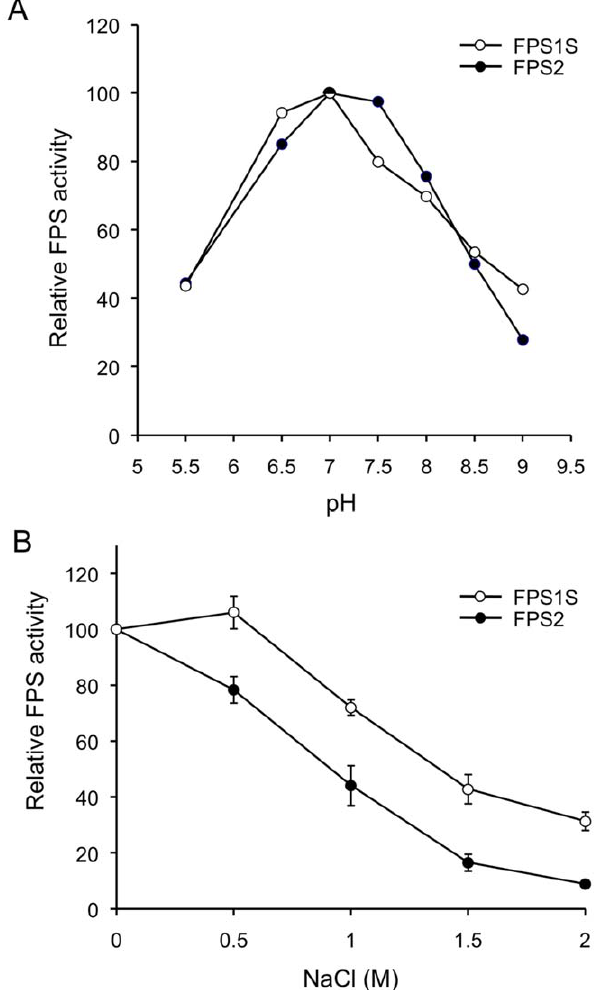
Figure 2. Effect of pH and NaCl on FPS1S and FPS2 enzyme activity. (A) FPS activity of purified FPS1S and FPS2 was determined at pH values ranging from 5.5 to 9.0 as described under Materials and Methods. Enzyme activities are expressed relative to the maximal activity values for FPS1S and FPS2. (B) Effect of NaCl on FPS1S and FPS2 enzyme activity. FPS activity of purified FPS1S and FPS2 was determined at the indicated NaCl concentrations. Enzyme activities are expressed relative to the activity values for FPS1S and FPS2 measured without NaCl. The mean values and SE were calculated from three independent